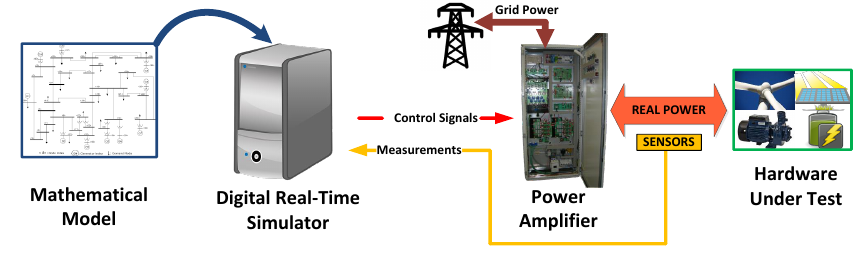
Figure 2. PHIL basic structure, identifying most representative subsystems: Mathematical model, Digital Real-Time Simulator (DRTS), Power Amplifier (PA), and Hardware Under Test